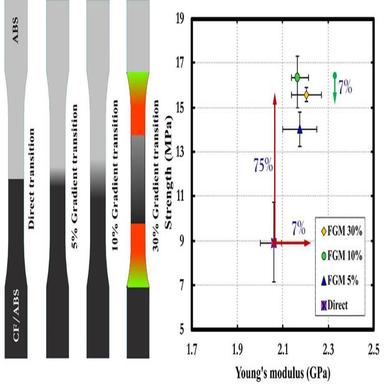
Comparison of FGM designs with respect to the direct transition.